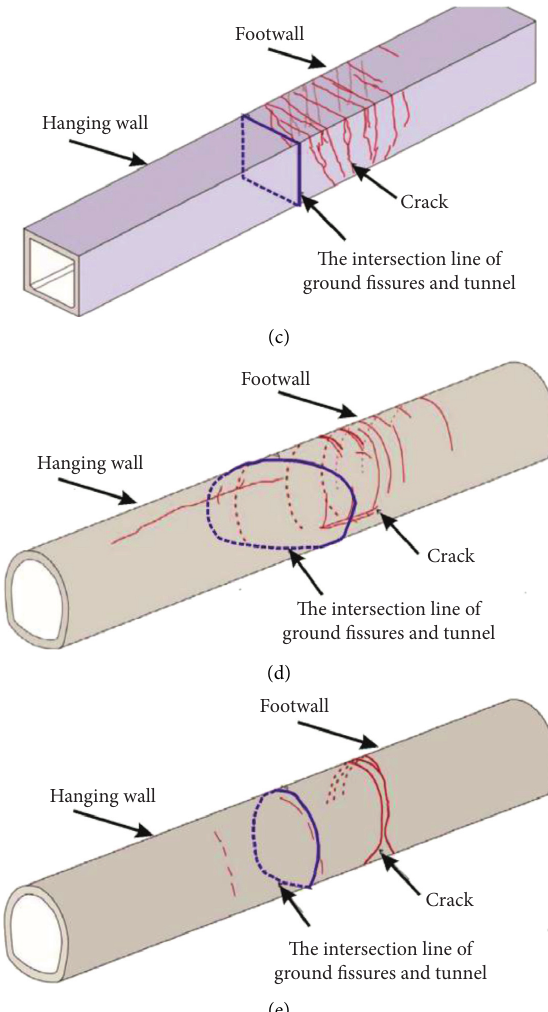
Figure 3: Common tunnel failure mechanism when crossing ground fissures. (a) The section of tunnel crossing ground fissures. (b, c) Previous study of open-cut box tunnel failure mechanism when crossing ground fissures. (d, e) Previous study of horseshoe-shaped tunnel failure mechanism when crossing ground